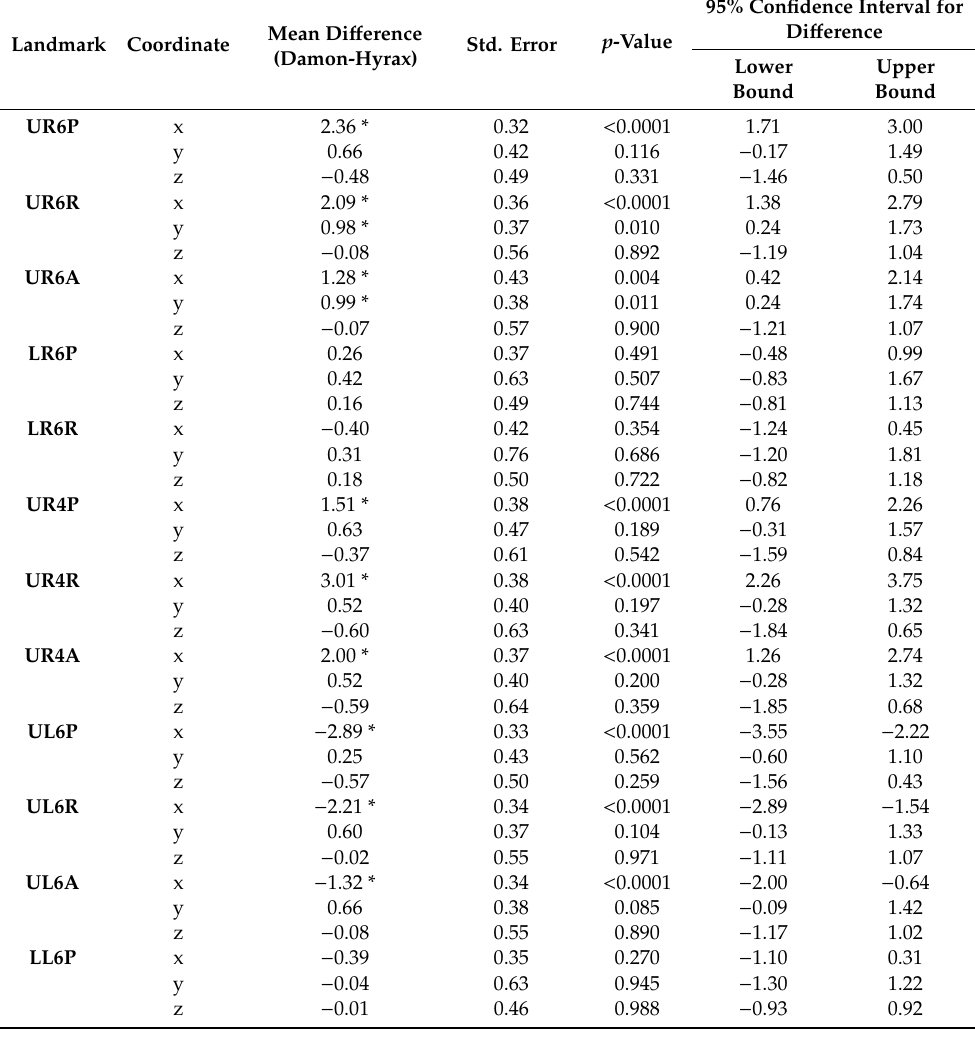
Table A2. Between-group pairwise comparisons (x = transverse, y = anteroposterior, z = vertical